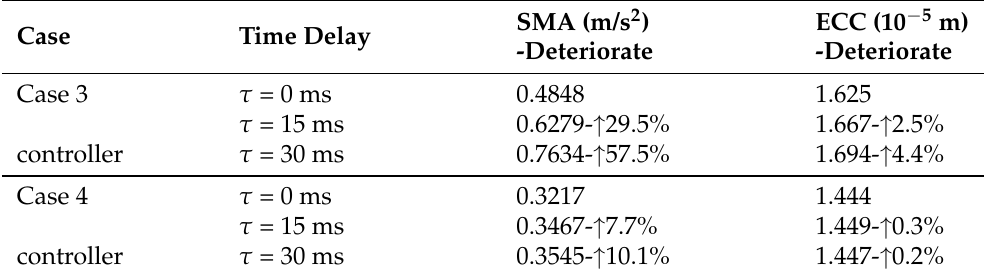
Table 3. The RMS optimization results for both